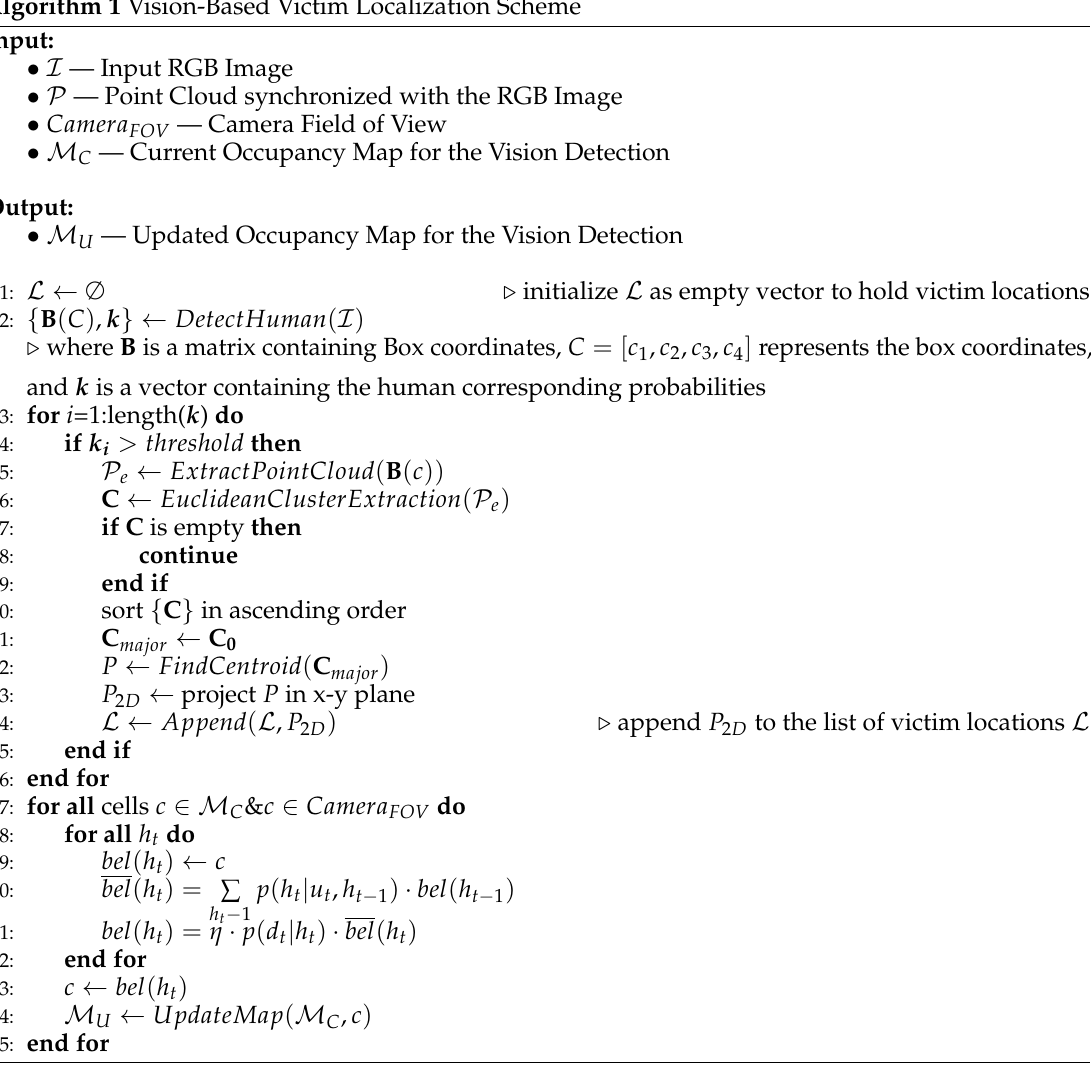
Algorithm 1 Vision-Based Victim Localization